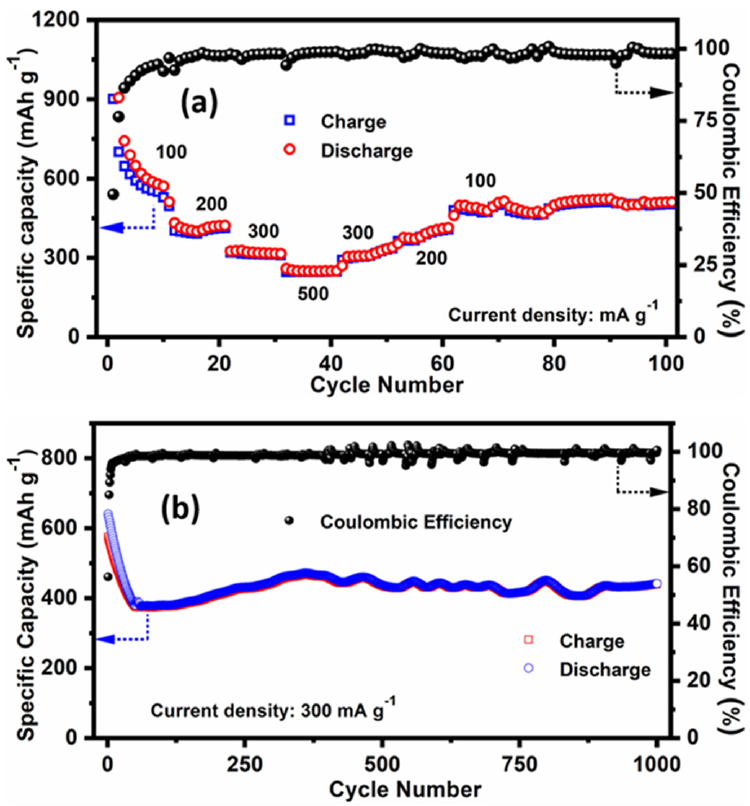
Figure 6. ( a ) Rate capabilities at different current densities (100 to 500 mA g − 1 ), and ( b ) long-life cycling performance at high current density (300 mA g − 1 ) with corresponding coulombic efficiency of FNS@GC electrode.